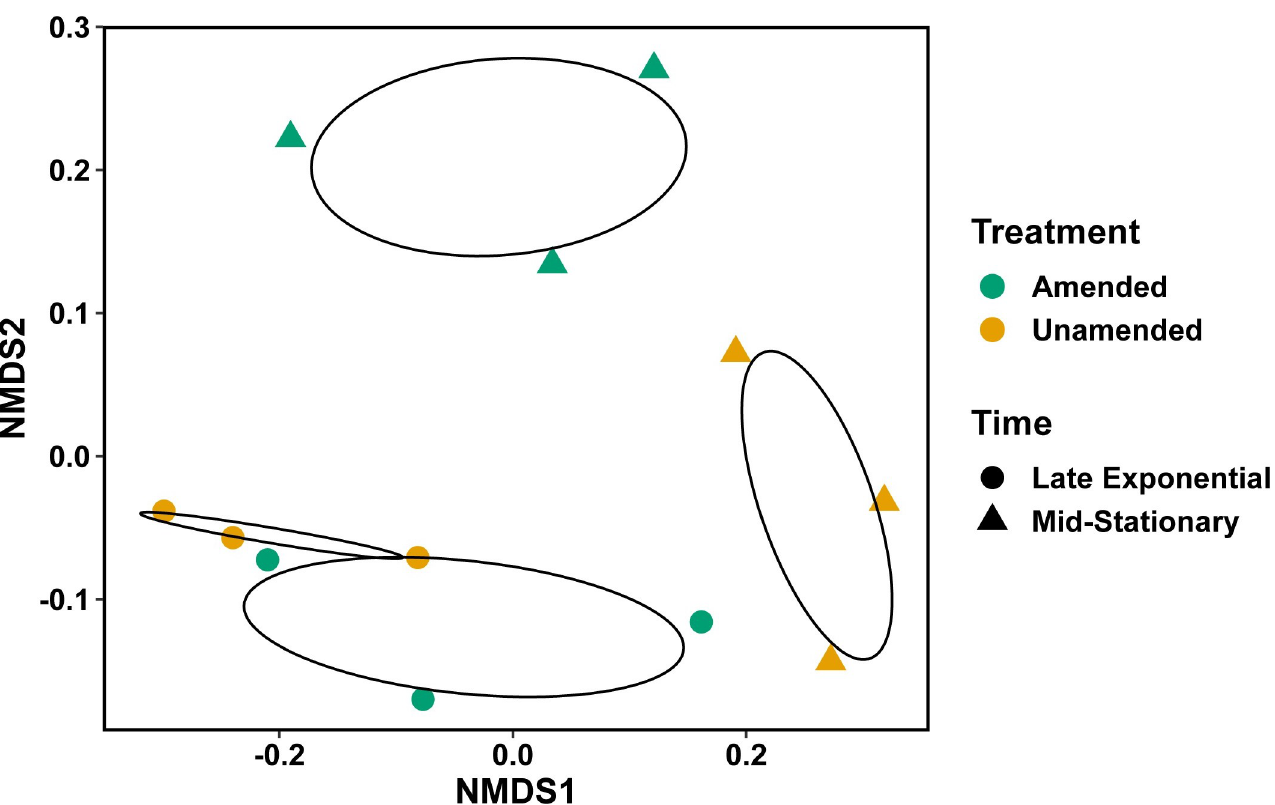
Fig 4. Non-metric multidimensional scaling (NMDS) ordination of metabolites in lignin-amended and unamended cultures for both late logarithmic and mid-stationary phase. Green represents lignin-amended and yellow represents lignin unamended. Circle indicates late logarithmic phase and triangle represents mid-stationary